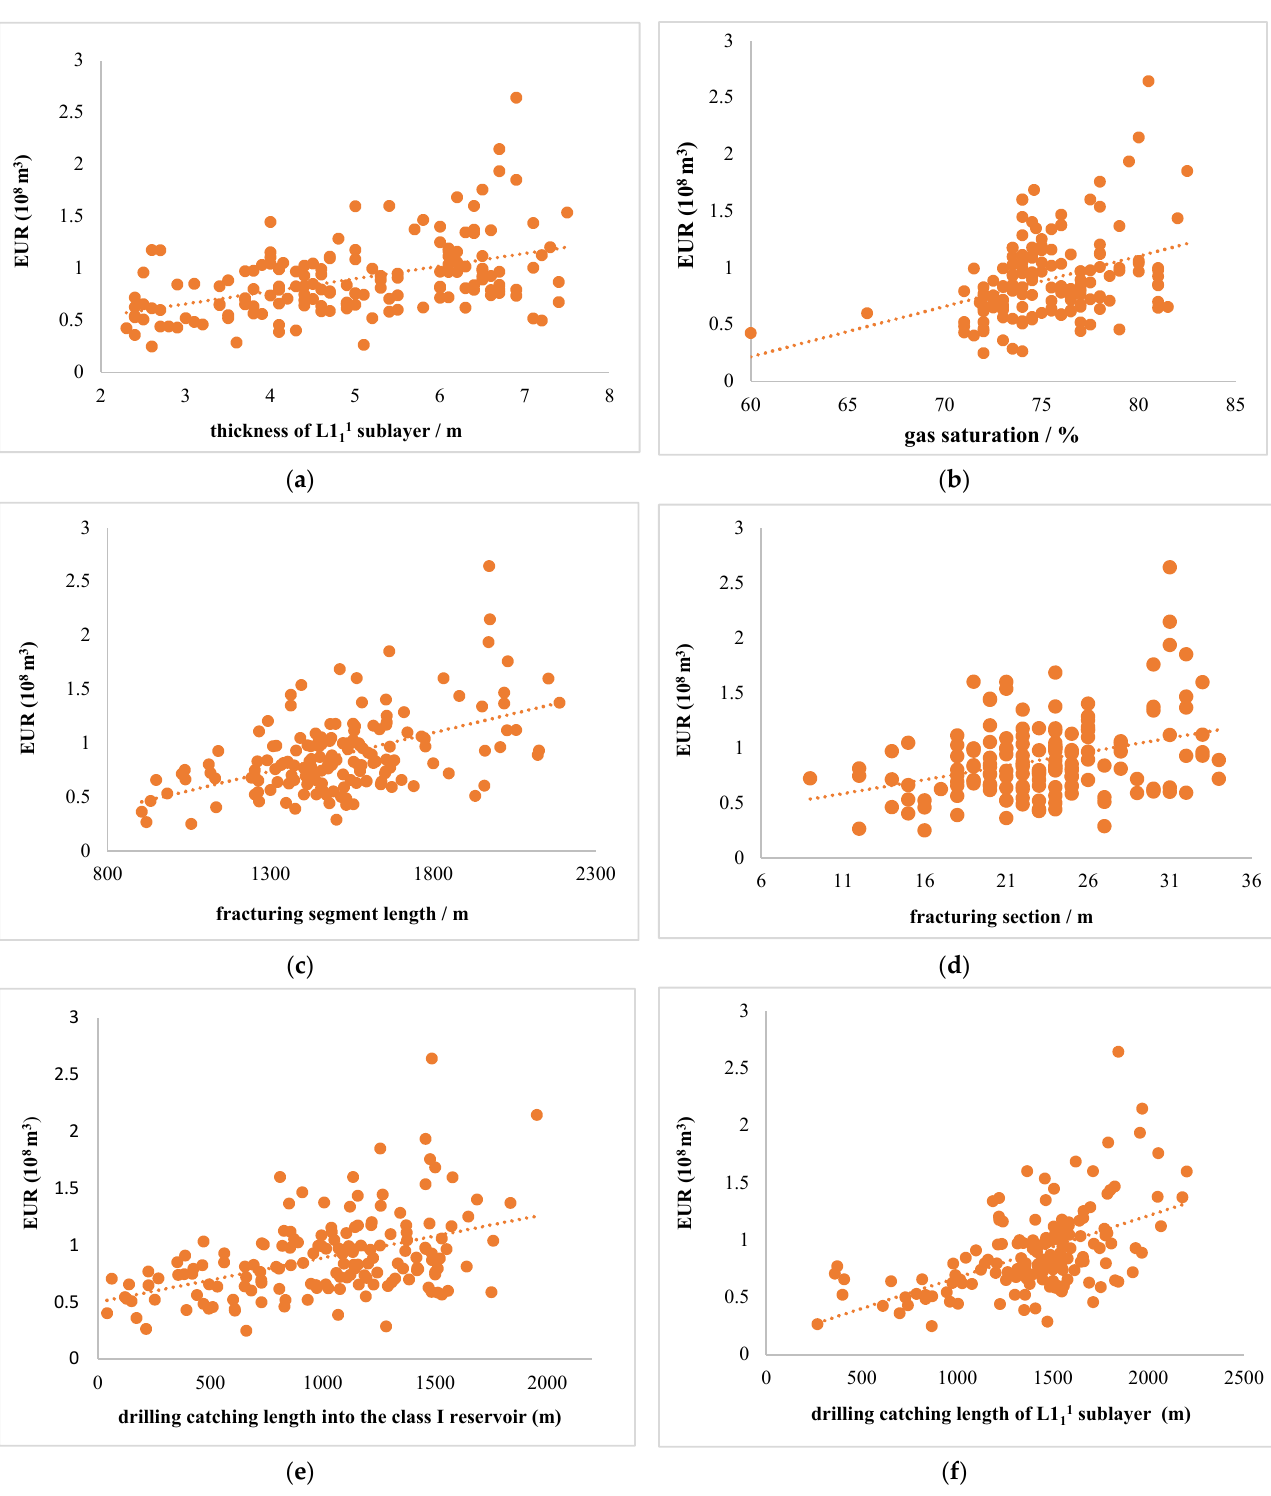
Figure 1. Scatter diagram of ( a ) EUR and thickness of L1 11 sublayer, ( b ) EUR and gas saturation, ( c ) EUR and fracturing segment length, ( d ) EUR and fracturing section, ( e ) EUR and drilling catching length into the class I reservoir, and ( f ) EUR and drilling catching length of L1 11 sublayer.